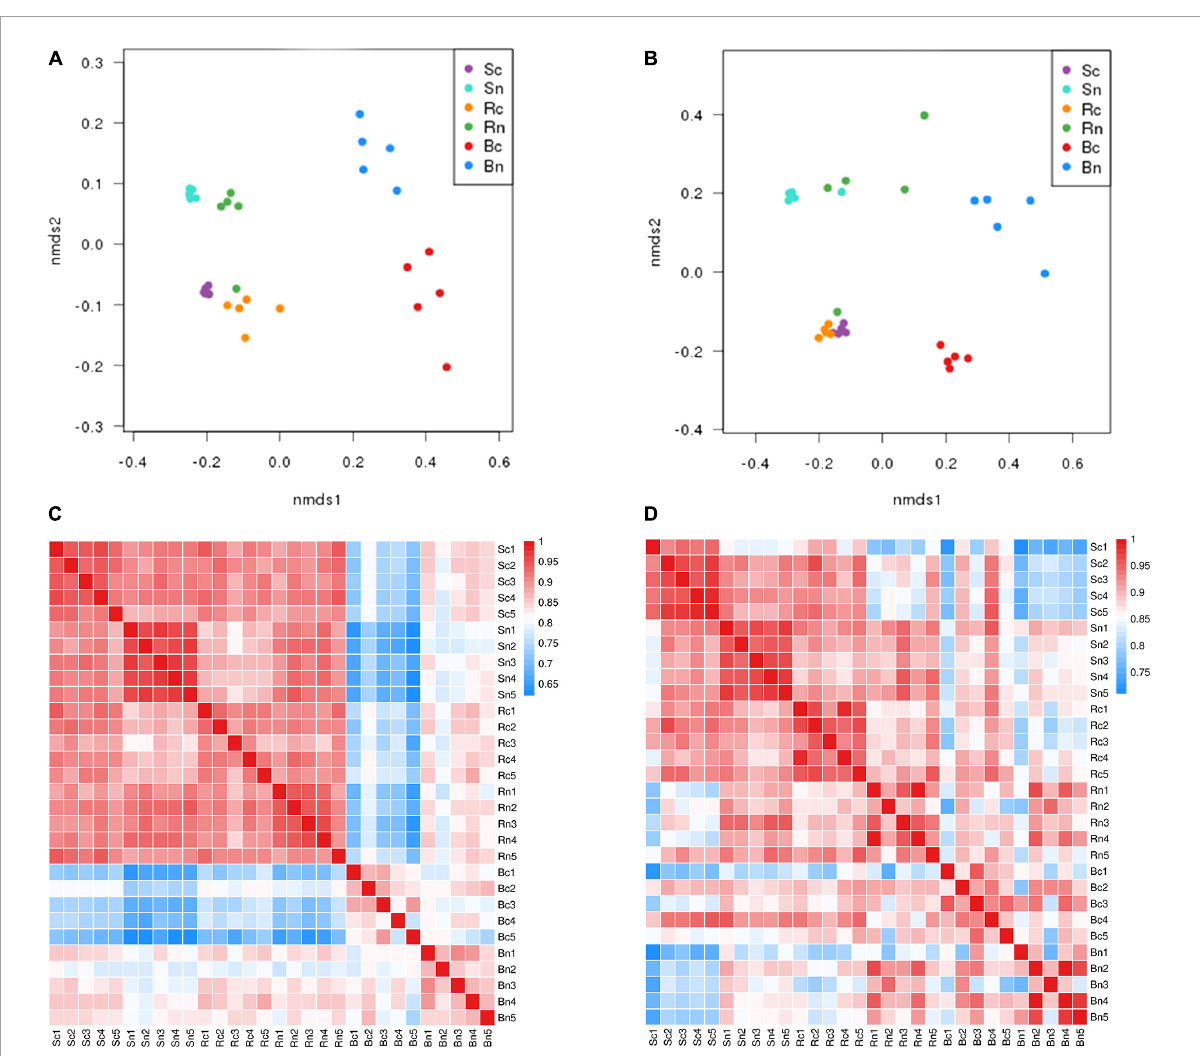
FIGURE2 Spearman clustering heatmap and Unweighted UniFrac NMDS of the bacterial and fungal communities. Panels (A,C) representing clustering heatmap and NMDS of the bacterial community; (B,D) representing clustering heatmap and NMDS of the fungal community. The color code indicated relative abundance, ranging from blue (low correlation) to red (high correlation). Sc, continuous cropping bulk soil; Sn, non-continuous cropping bulk soil; Rc, continuous cropping rhizosphere soil; Rn, non-continuous cropping rhizosphere soil; Bc, continuous cropping sugar beetroot; Bn, non-continuous cropping sugar